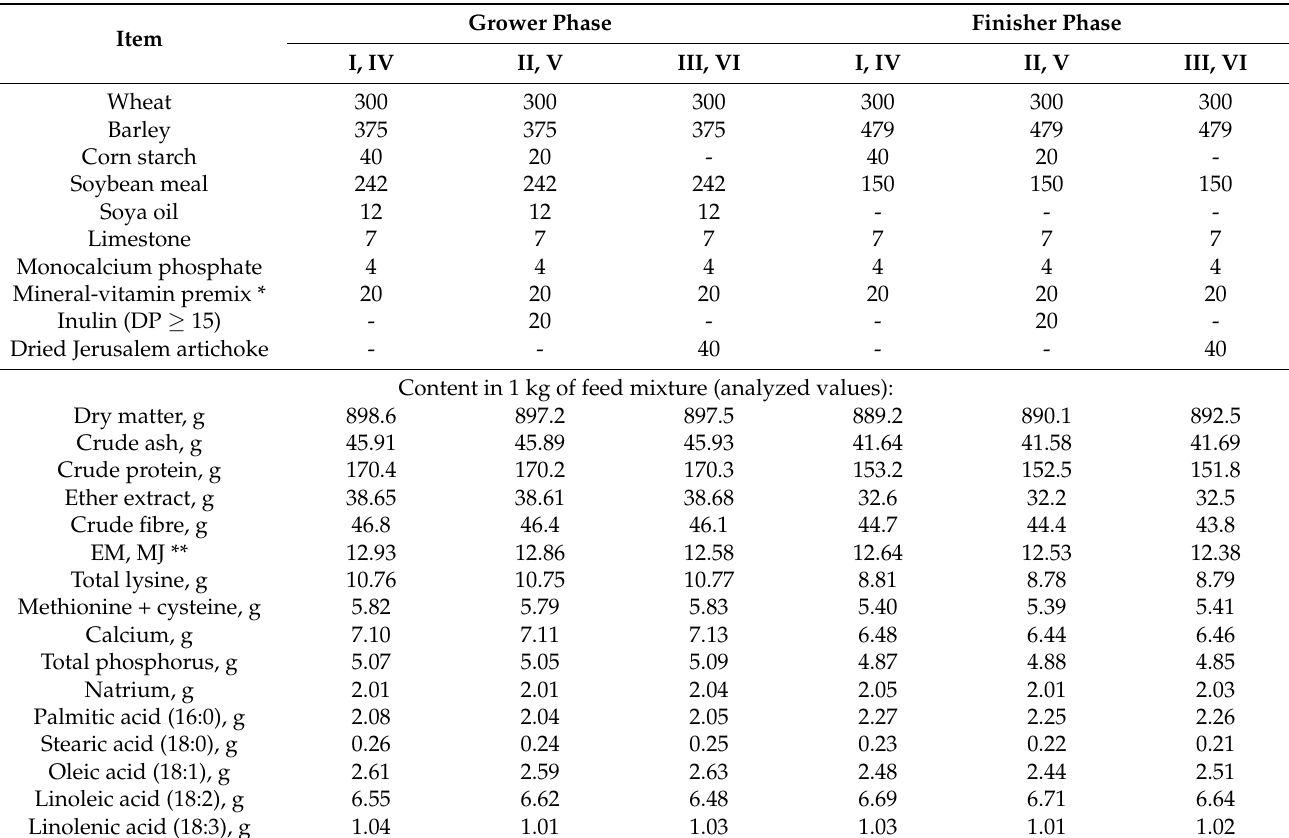
Table 2. Composition (g/kg) and nutritive value of growing–finishing pig